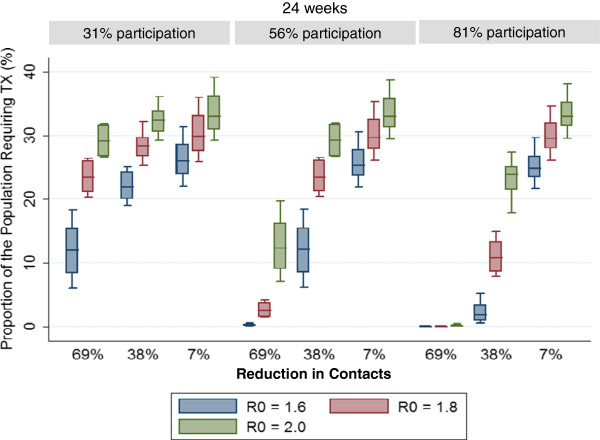
The median (line within the shaded box), 25th and 75th percentile values (top and bottom of shaded box), and upper and lower adjacent values (error bars) proportion of the Canadian population expected to require antiviral treatment (Y-axis) during a severe pandemic as a function of viral transmissibility and the magnitude of change maintained for 24 weeks. Each box represents 9 individual simulation runs using a range of pre-existing immunity values from 0-40%. We examined three different levels of behaviour change uptake where between 31% and 81% of the Canadian population engages in social distancing behaviour. The magnitude of the behaviour change ranged from only a 7% reduction in contacts to a 69% reduction in contacts for all scenarios.